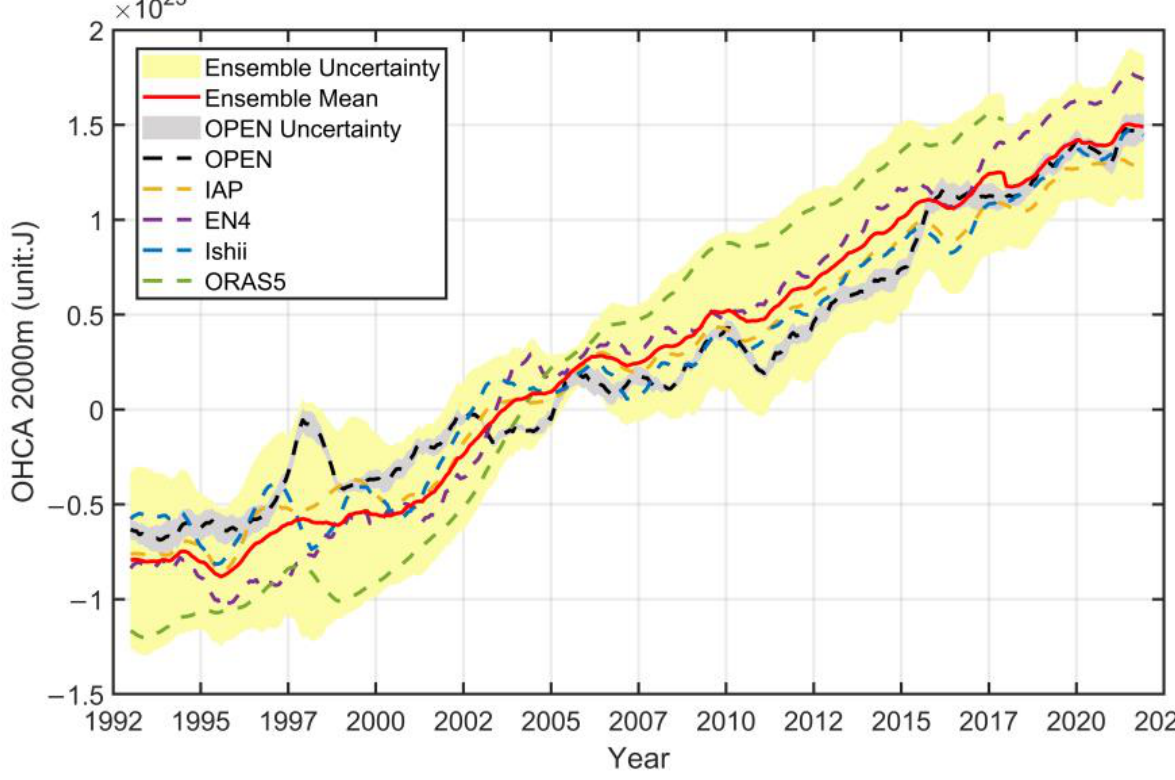
Figure 1. Time series of monthly global OHC anomalies for 0–2000 m over the January 1993– December 2021 period (unit: J). Ensemble mean (solid red) is represented by the mean value of the OPEN (dashed black), IAP (dashed yellow), EN4 (dashed purple), Ishii (dashed blue), and ORAS5 (dashed green) datasets. The yellow shade corresponds to double standard deviation for the ensemble and the grey shade corresponds to double standard deviation for the OPEN dataset. A 12 month running mean is used to filter high frequency signals. The reference period for OHC anomalies is 1993–2015 for all the datasets.